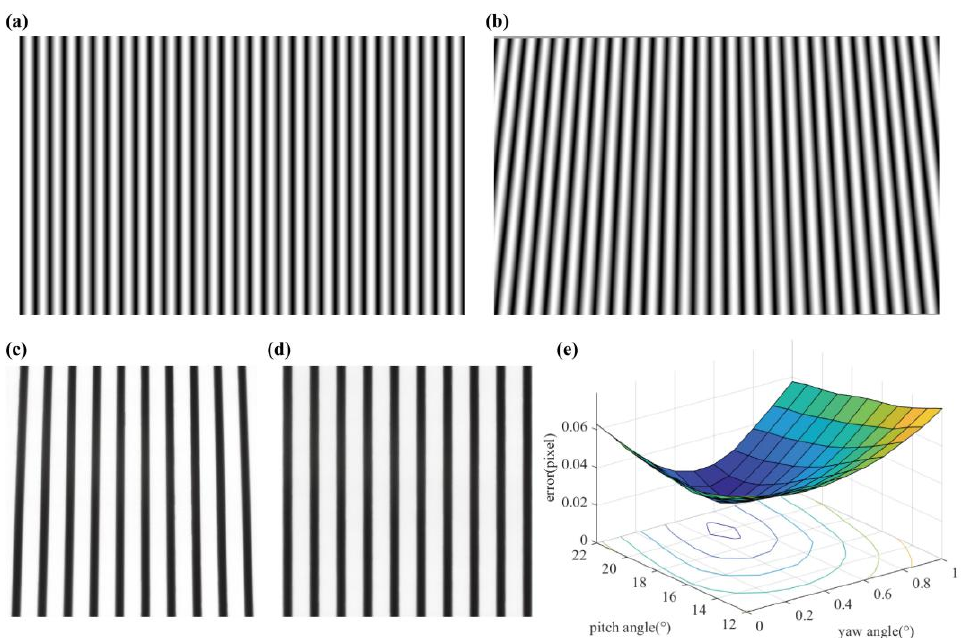
Figure 5. Keystone correction: ( a ) sinusoidal pattern before correction; ( b ) sinusoidal pattern after correction; ( c ) ROI reflectance image before correction; ( d ) ROI reflectance image after correction; ( e ) correction error gradient map.